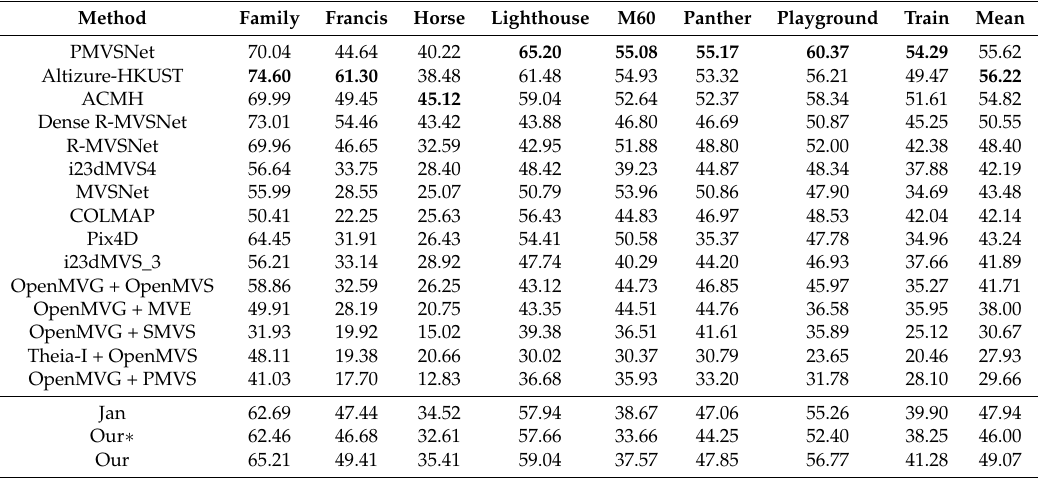
Table 4. Leaderboard 1 of the methods and the result of the proposed method with respect to F-score on the intermediate set of Tanks and Temples dataset [40].